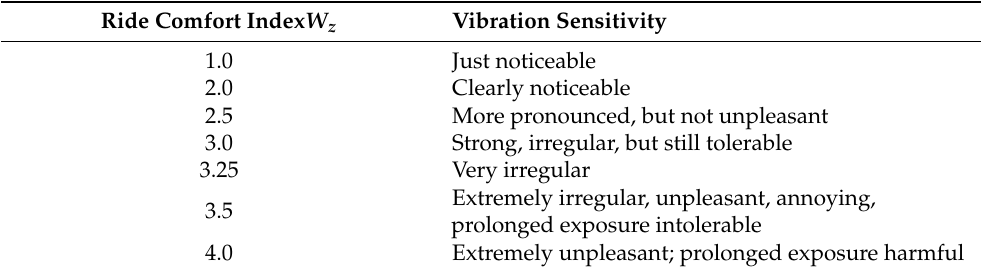
Table 3. Scale for the ride comfort index W z .